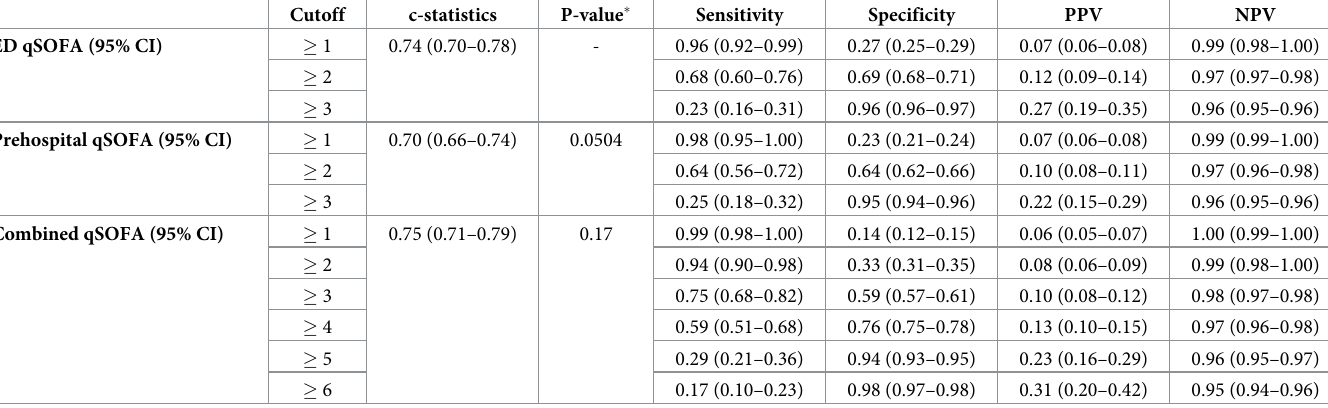
Table 4. Predictive abilities of the ED qSOFA, prehospital qSOFA, and combined qSOFA for septic shock.